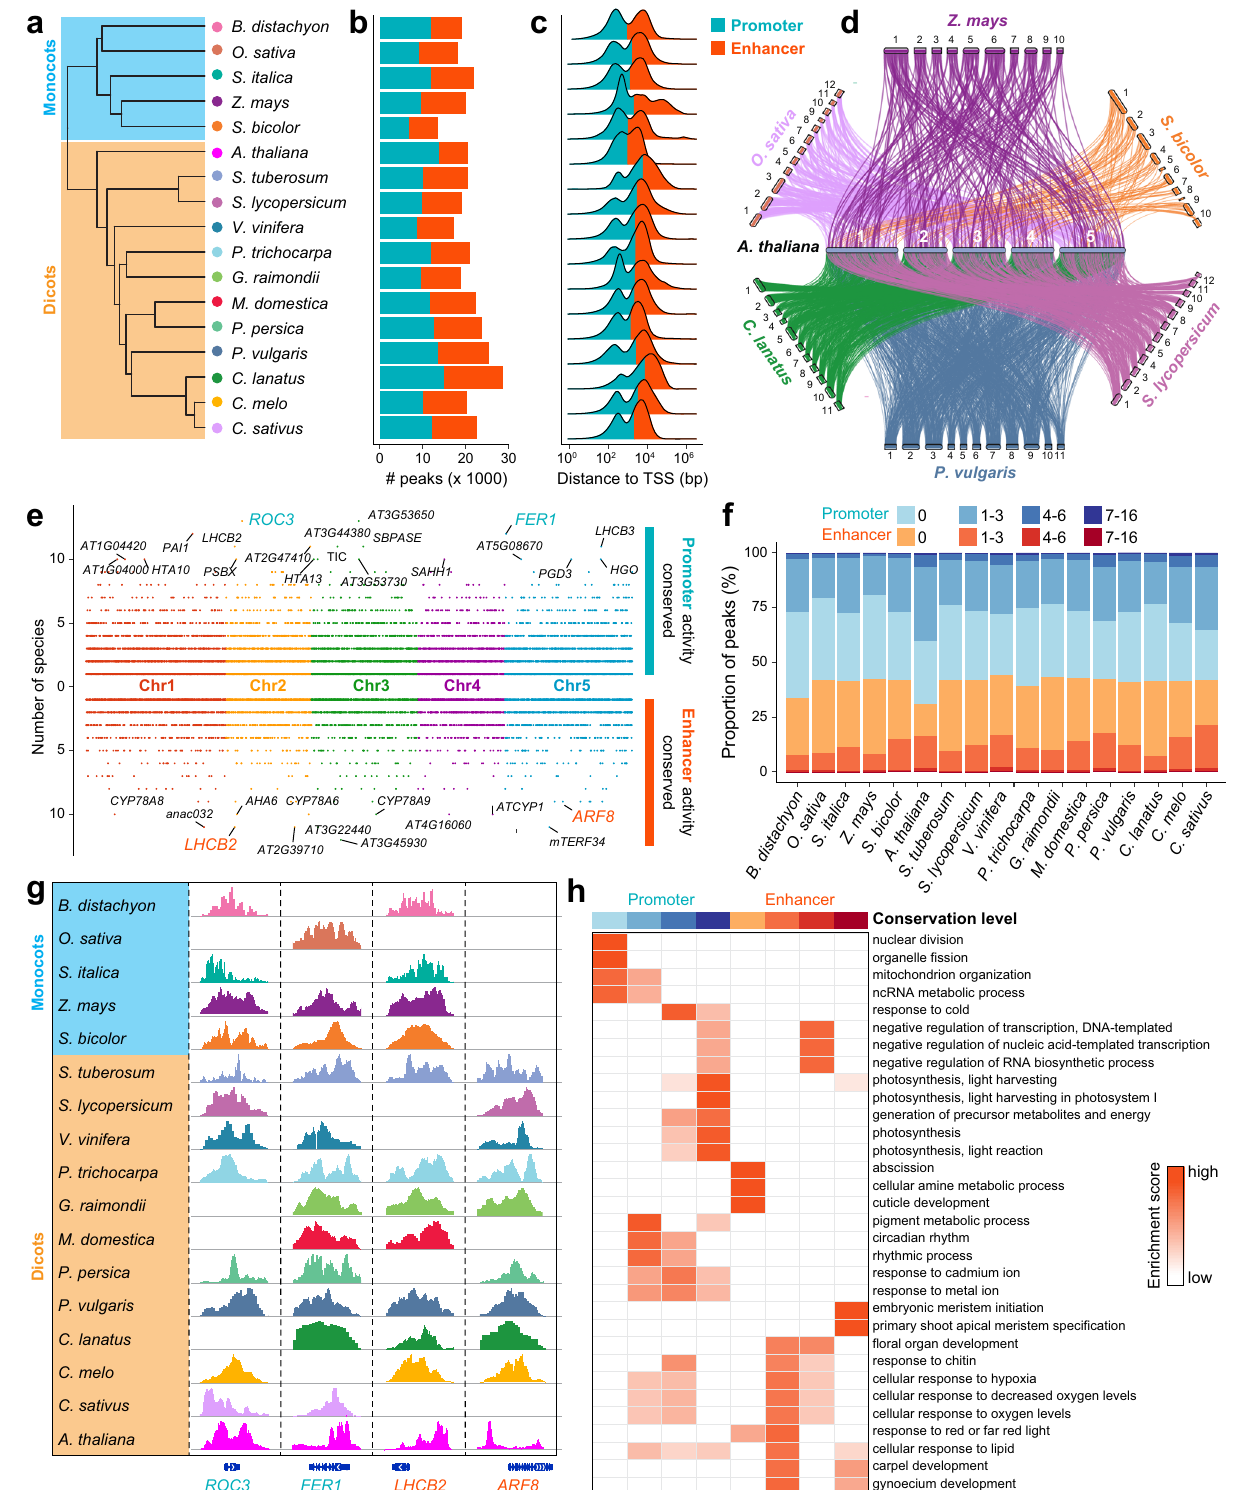
Fig. 6 Evolutionarily tracking plant promoters and enhancers. a Phylogenetic tree showing the evolutionary relationships of plant species used in the analysis, including fi ve monocots and twelve dicots. b The number of predicted promoters and enhancers in each species. c Distance of peak summits to the nearest transcription start site (TSS). d Sankey plot showing conserved regulatory elements among seven representative species, using Arabidopsis as a reference. Each line refers active regulatory element (promoter or enhancer) is alignable to the Arabidopsis genome. e Dotplots showing the number of species in which the Arabidopsis promoter (above) or enhancer (below) is alignable. Top conserved promoters and enhancers are labeled and four regulatory regions active in different plant species. h Enrichment analysis of gene ontology (GO) biological pathways for promoters and enhancers with different degree of conservation. Source data are provided as a Source Data fi